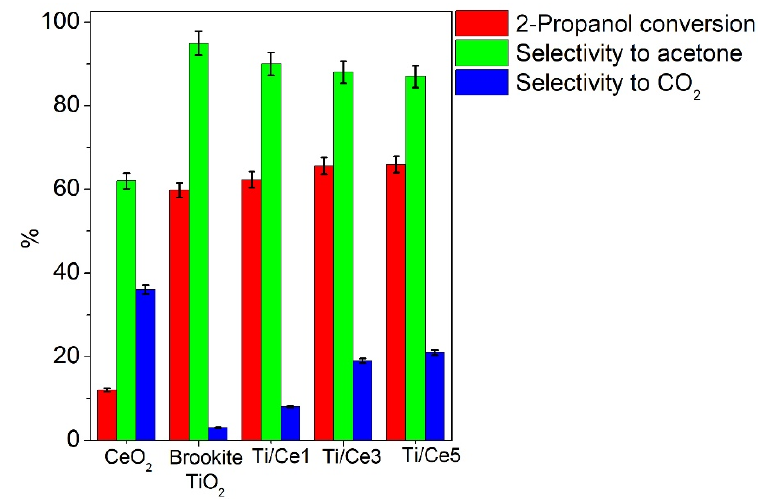
Figure 7. Photocatalytic oxidation of 2-propanol at room temperature, under simulated solar irradiation for 2 h over the investigated catalysts.